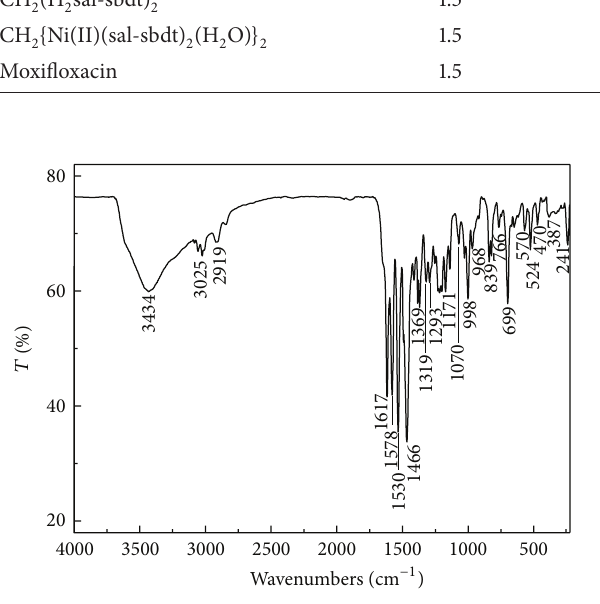
Figure 1: FT-IR spectra of the title complex.